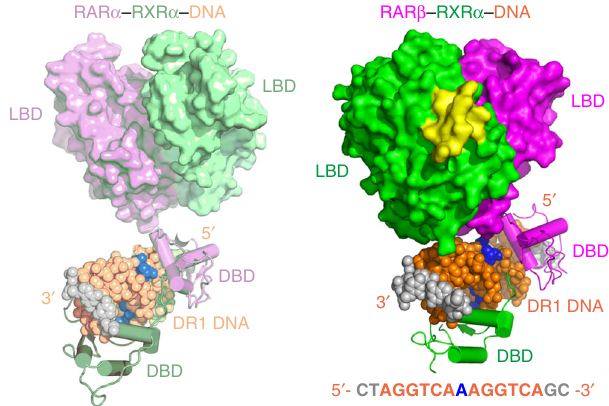
Fig. 5 Signi fi cant differences between a previously proposed structural model of RAR α – RXR α heterodimer on DR1 by Rochel et al. 7,35 (left) and the current crystal structure of RAR β – RXR α on DR1 (right). The proteins and DNA are colored in the same way as in both fi gures. The DBD domains from two complexes are positioned in the same orientation to clearly highlight the overall differences in quaternary structures. Note that in these two models, the LBD – LBD segments have clearly different (rotational and translational) positionings with respect to both their DR1 DNA and